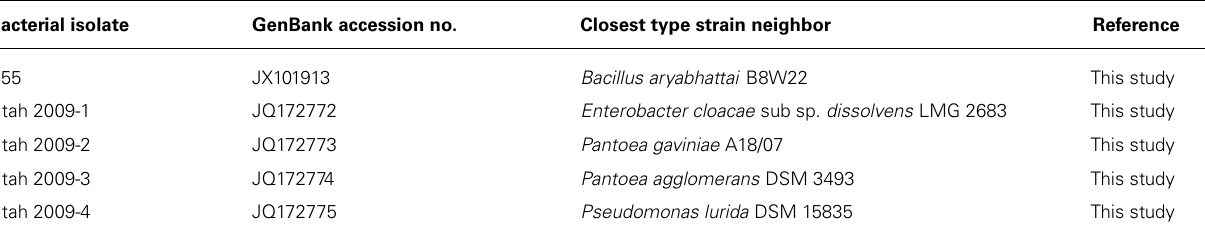
Table 1 |Accession numbers of bacterial isolates used in this study.